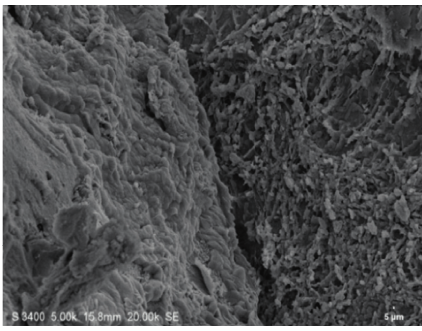
Figure 10: 30 freeze-thaw cycles. Figure 11: 60 freeze-thaw